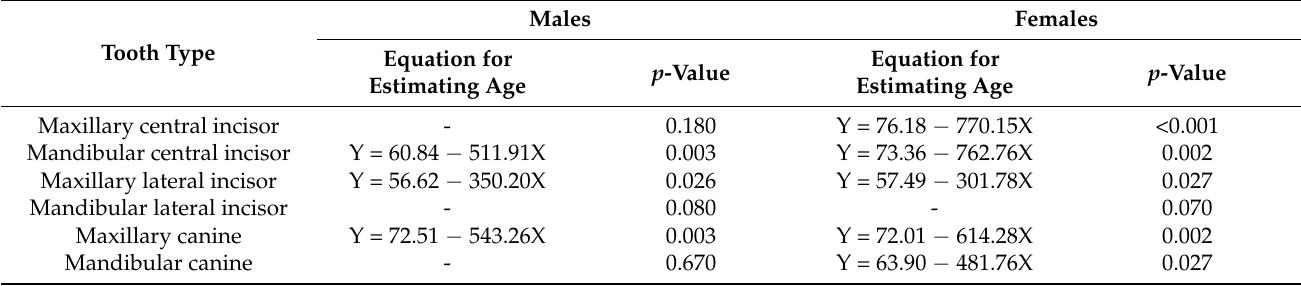
Table 7. Equations for estimating age in different